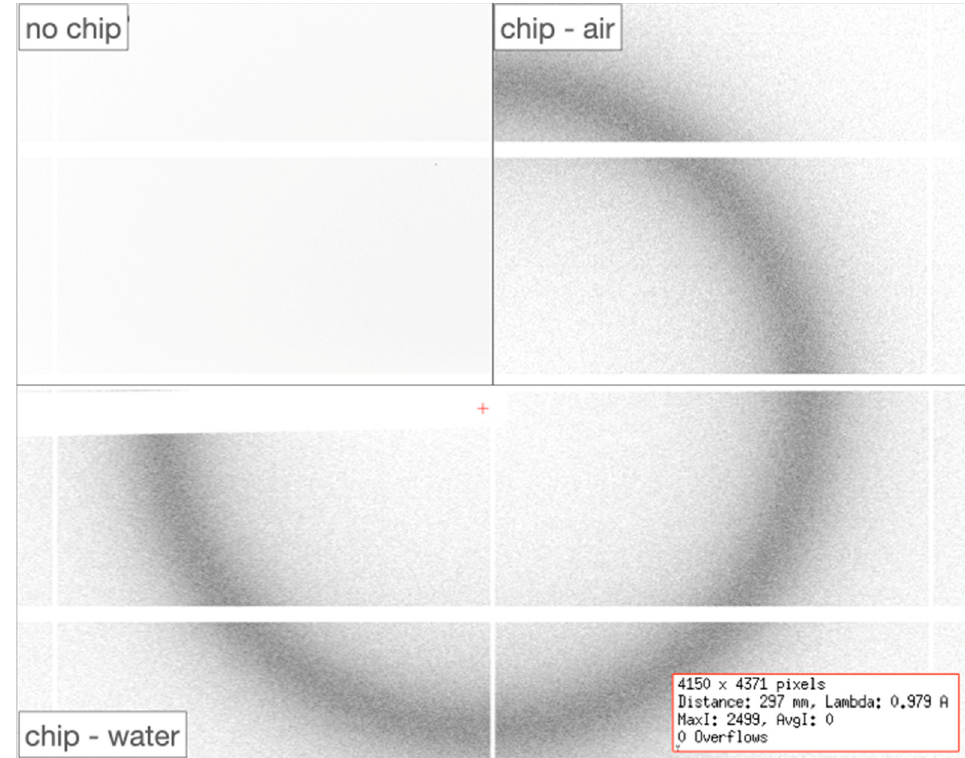
Figure 3. Diffusion background of the COC chip loaded with water ( chip-water) , empty of any liquid ( chip-air ), in comparison with classical air scattering ( no chip ), as recorded at the beamline PROXIMA-1 of Synchrotron SOLEIL. The values of overflows, maximum intensity, and averaged intensity for the water-loaded chip are indicated in the bottom-right inset.